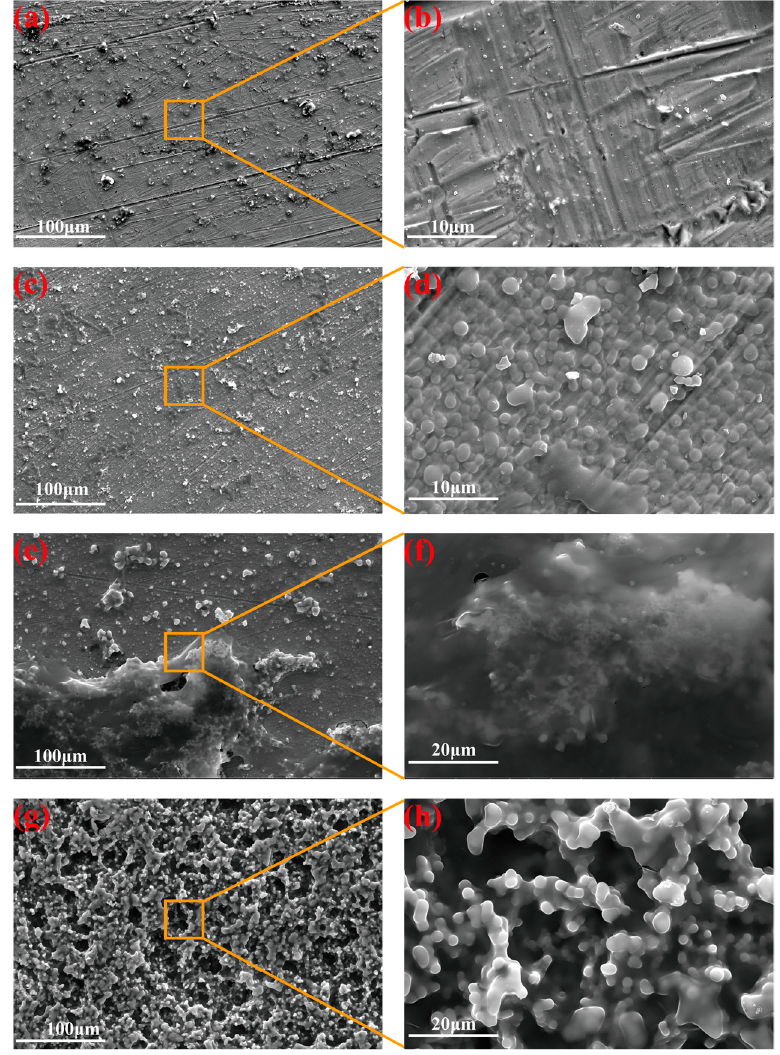
Figure 3. FE-SEM images of the top-view of the silica films deposited on Cu with different deposi- tion times (applied potential at − 1.2 V vs. Ag/AgCl): ( a , b ) 100 s; ( c , d ) 200 s; ( e , f ) 400 s; ( g , h ) 600 s.